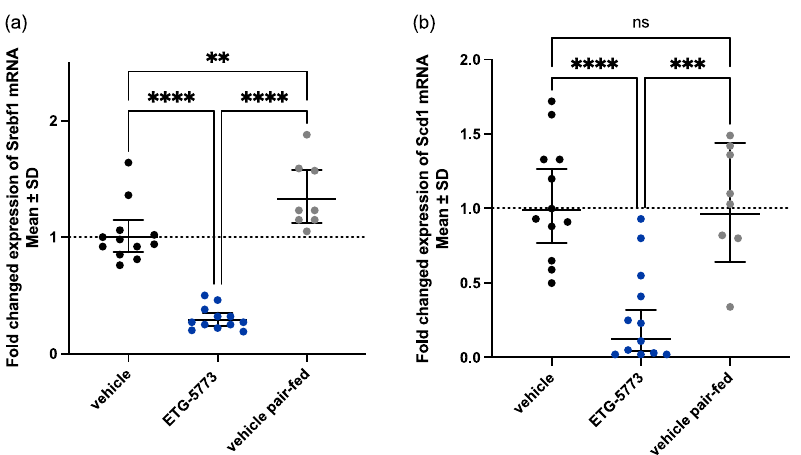
Figure 5. Hepatic mRNA expression levels of key genes involved in lipogenesis in DIO mice after the 28-day treatment period. Animals were treated orally twice a day with ETG-5773 at 15 mg/kg or with the corresponding vehicle or vehicle in the pair-fed group: ( a ) mRNA expression of sterol regulatory element-binding transcription factor 1 ( Srebf1 ); ( b ) mRNA expression of the stearoyl-CoA desaturase ( Scd1 ) gene. ** p < 0.01, *** p < 0.001, **** p < 0.0001 as indicated, ns: non-significant. ANOVA mean SD, n = 12 vehicle and ETG-5773, n = 8 pair-fed.